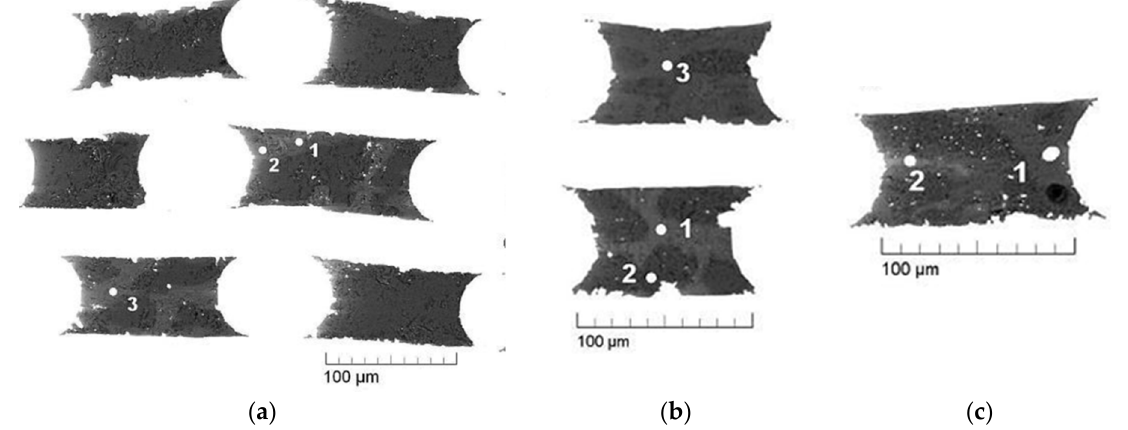
Figure 2. SEM-micrographs of fragments of a cross-section of a specimen with fibres crystallised with a crystallisation rate of ~2 mm/min; α = 0.032. The results of the X-ray microanalysis in the points shown in the micrographs are presented in Table 1.